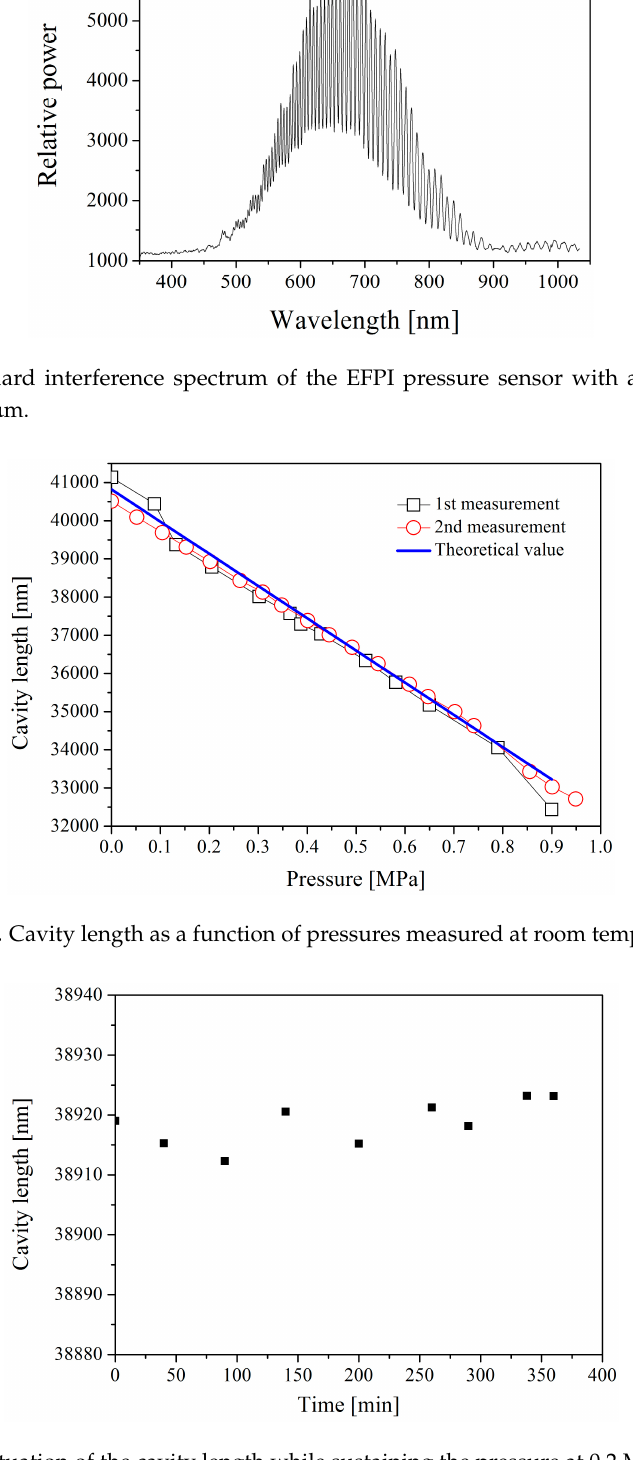
Figure 11. The fluctuation of the cavity length while sustaining the pressure at 0.2 MPa for 400 min at room temperature.